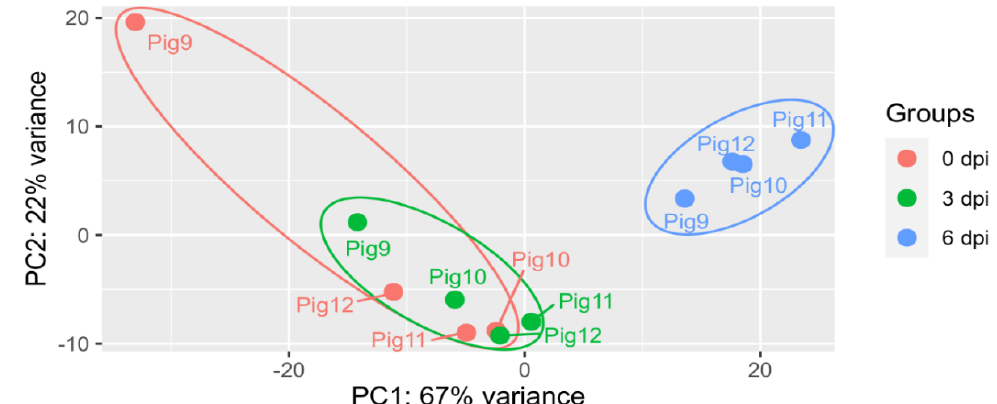
Figure 1. PCA across different sampling days. Pigs were inoculated intranasally with ASFV/POL/2015/Podlaskie at 0 dpi and euthanised at 6 dpi. Blood samples were collected at 0 dpi (prior to inoculation), at 3 dpi and at 6 dpi (before euthanasia) from each of the 4 pigs. PBMCs were purified from the blood and poly(A)+ mRNA purified and analysed by sequencing (see Materials and Methods). Approximately 27 – 42 million reads were obtained from each sample and assessed using PCA. The samples from each pig (9 – 12) on each sampling day are indicated.